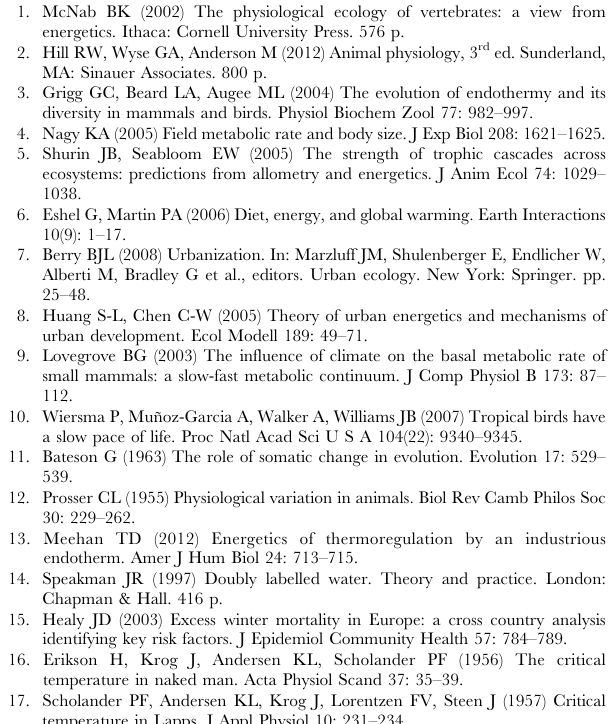
equation yields a unitless value, which equals T comfort in u C. To obtain the equations listed in the table, some of which (those for bolded clothing types) are plotted in Fig. 4B, we applied the first- order model in Fig. 1A, assuming T LC = T comfort , T b =37 u C, and resting metabolic rate = 104 W, the expected metabolic rate of a